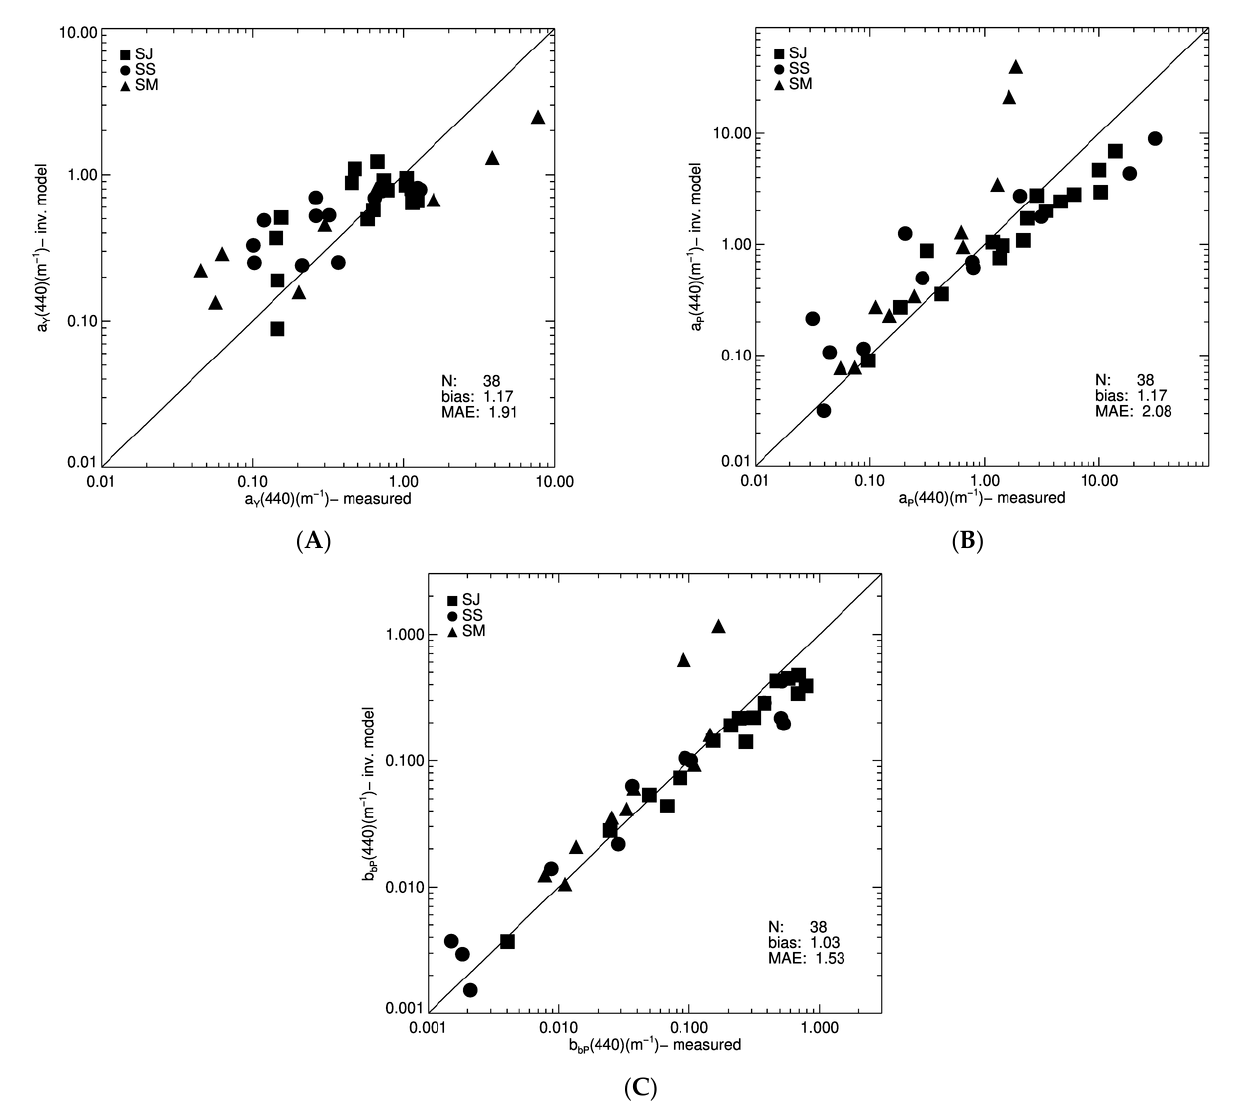
Figure A2. Predictive error estimates of the optical inversion model using leave-one-out cross validation. Measurements of uT are used as an input to retrieve ( A ) a Y (440), ( B ) a P (440) and ( C ) b bP (650).